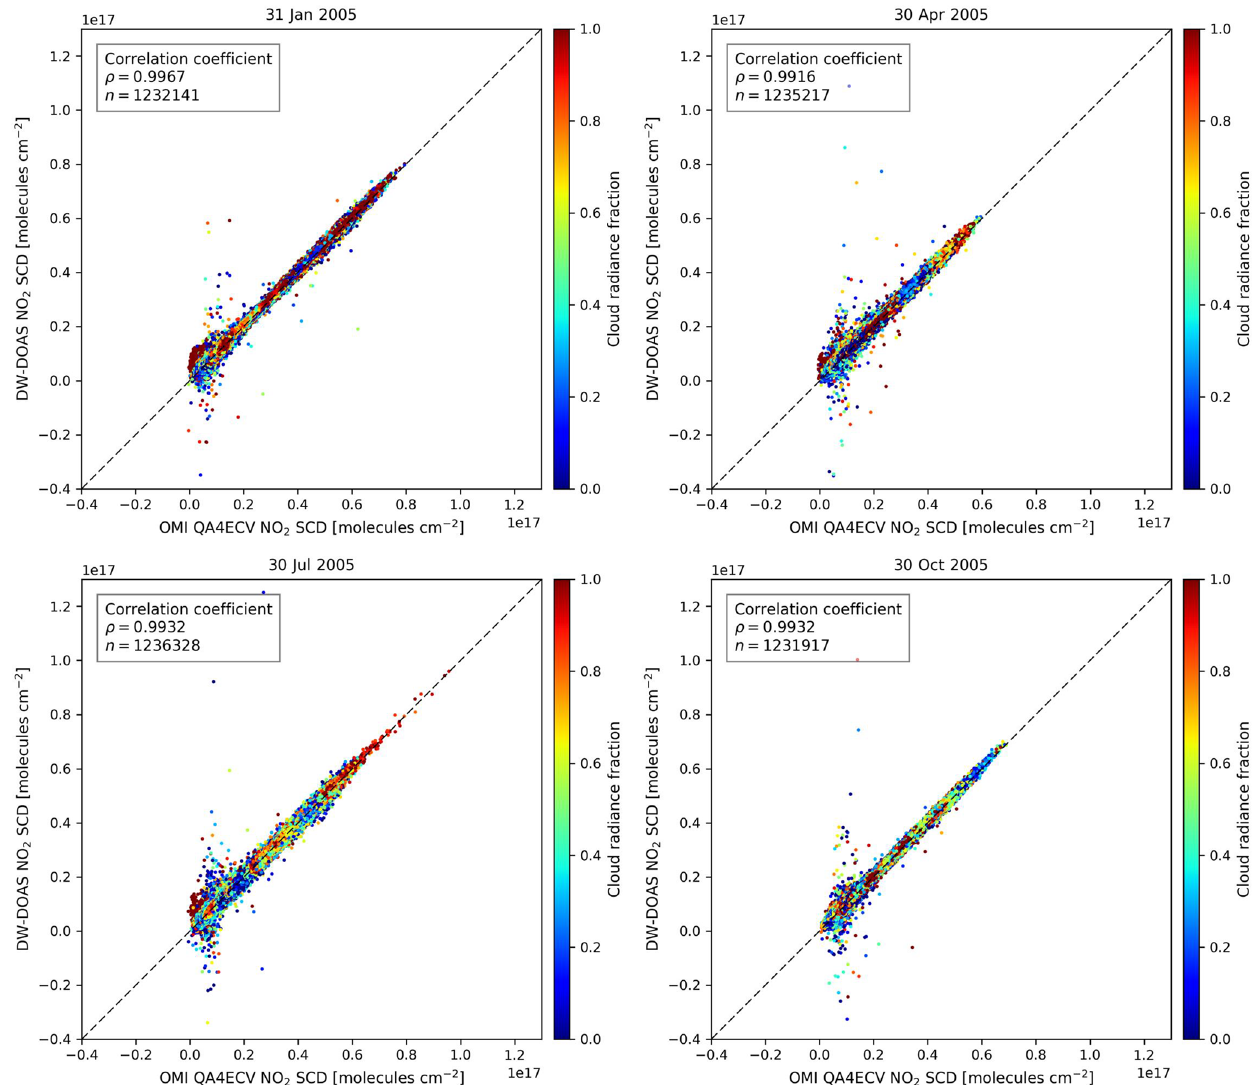
Figure 6. Correlation plots of DW-DOAS and QA4ECV global NO 2 SCD data used in Fig. 5. Pixels in the region affected by the SAA (approximated by a rectangle of latitudes [6 ◦ S, 40 ◦ S] and longitudes [70 ◦ W, 16 ◦ W]) have been filtered